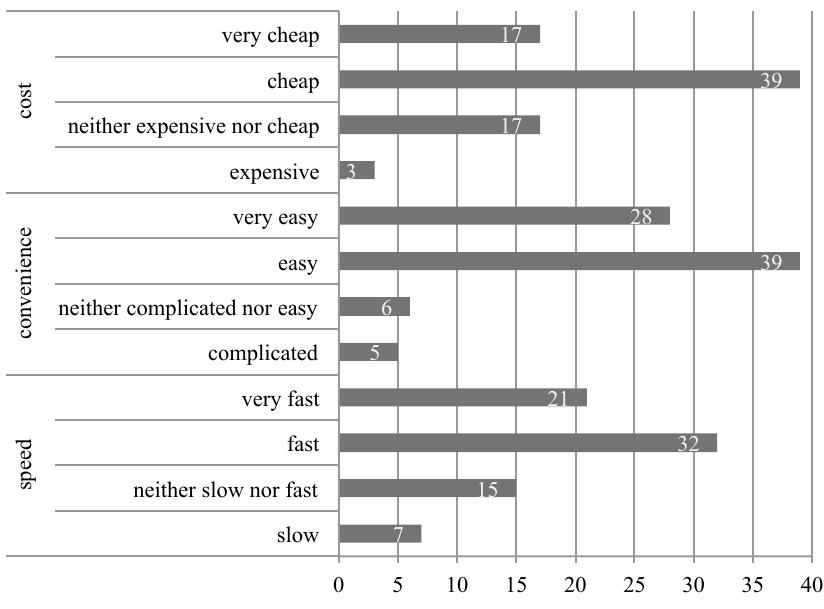
Fig. 6. Polish consumers’ opinions on traditional payment instruments One of the survey purposes was to establish the Polish consumers’ knowledge